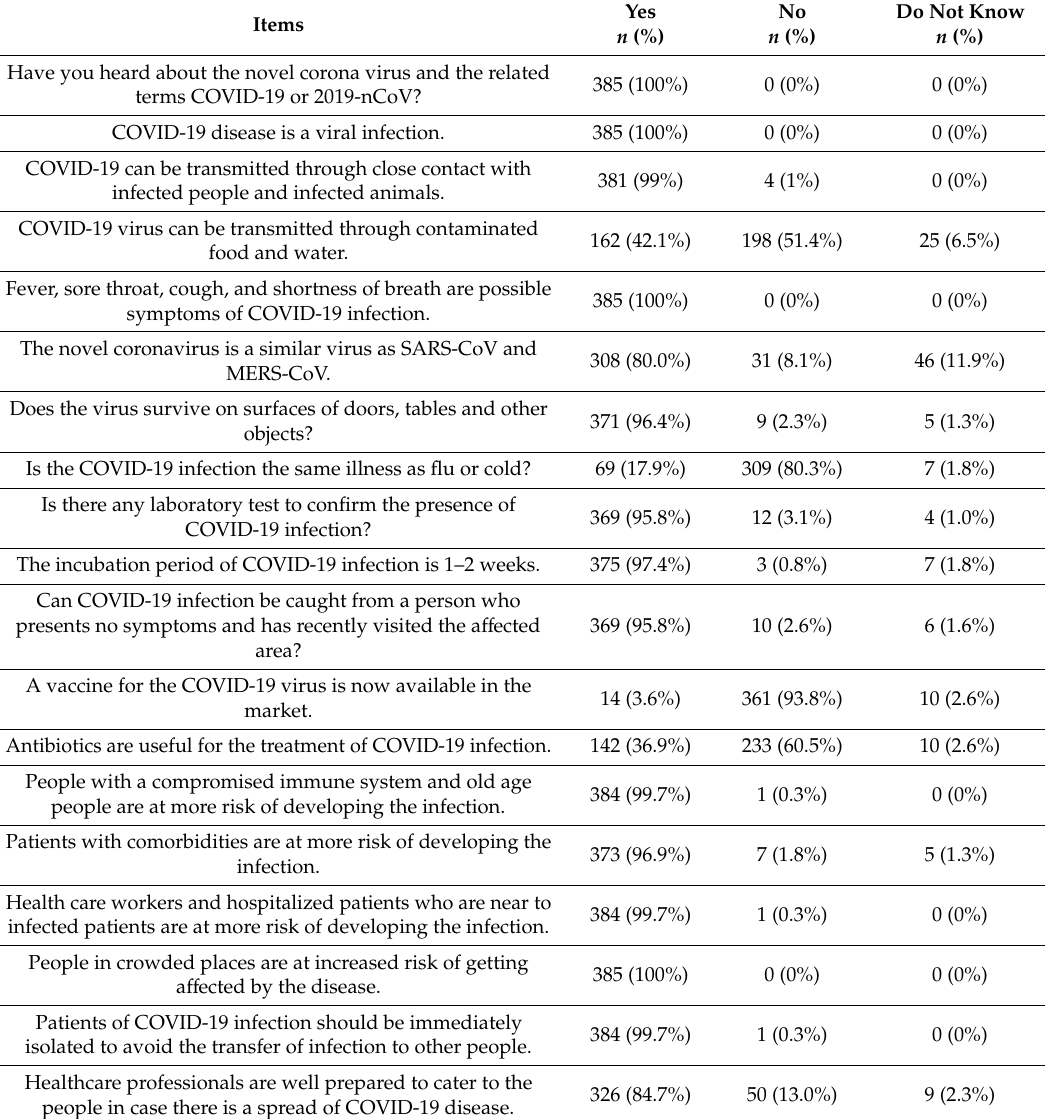
Table 2. Responses to COVID-19 knowledge